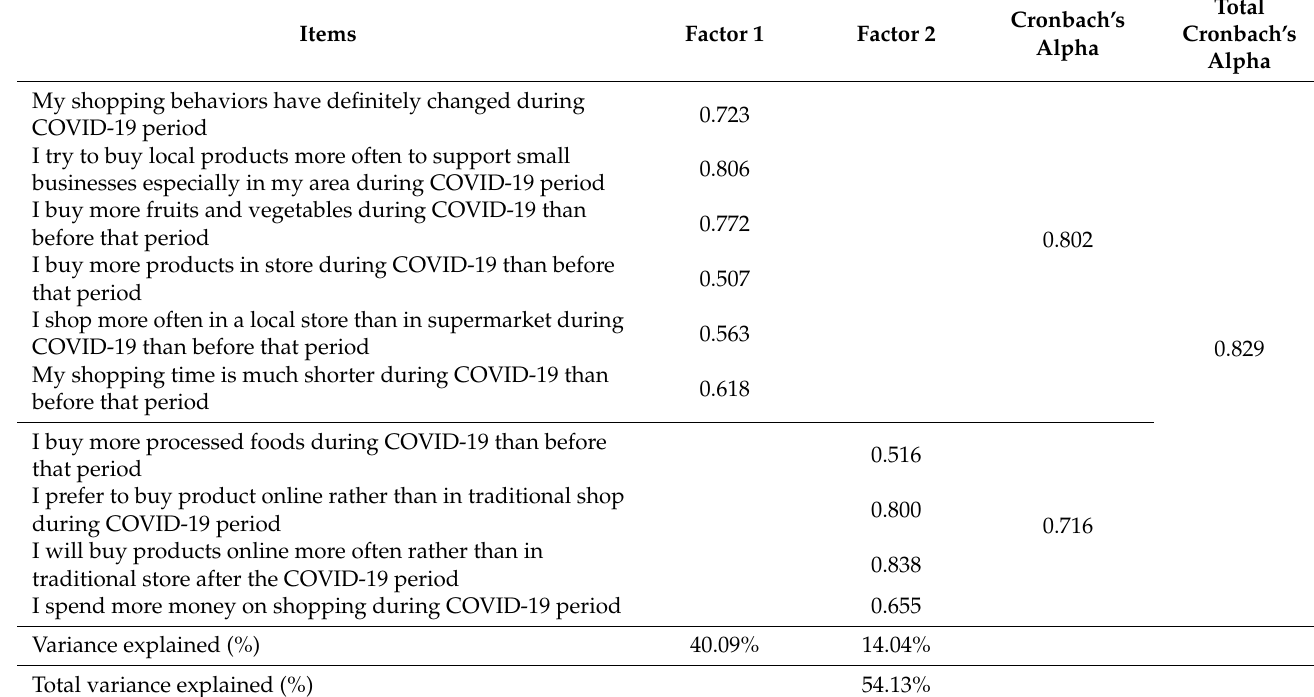
Table 3. The results of